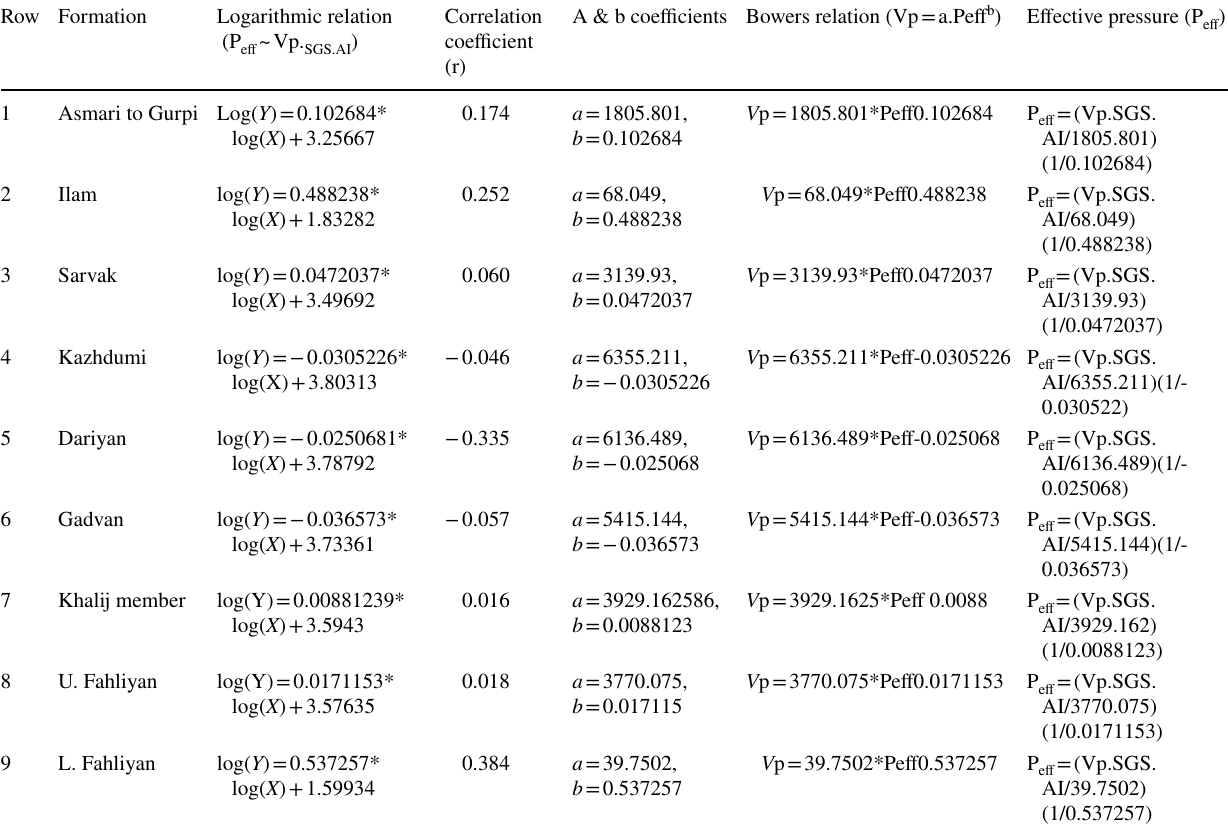
Table 2 Calculation of Bowers coefficients based on the MDT and DST effective pressure against the completed velocity log (VP kriged_AI)